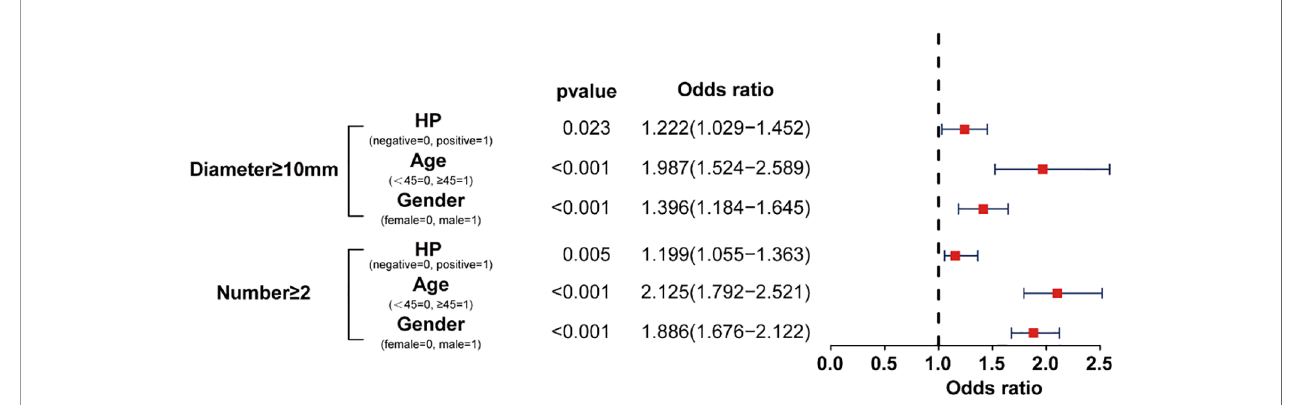
FIGURE 3 | OR value of HP, gender, and age for the size and numbers of CPs.